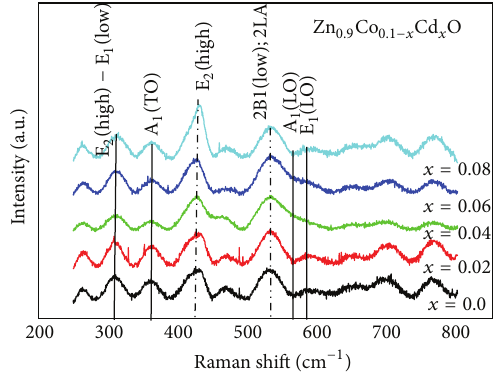
Figure 2: Raman spectra of Zn 0.9 Co 0.1−𝑥 Cd 𝑥 O ( 𝑥 = 0.0, 0.02, 0.04, 0.06, and 0.08).